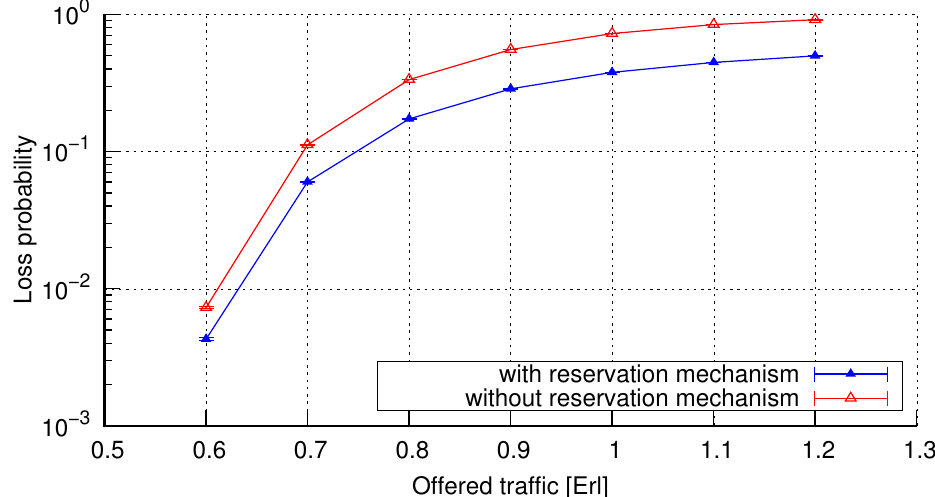
Figure 14. Loss probability for calls of class 4 (privileged class) in System